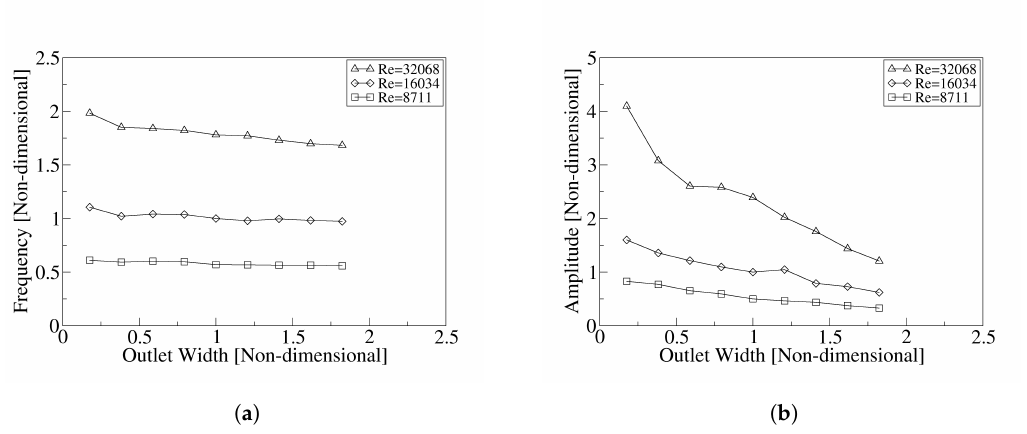
Figure 7. Fluidic oscillator output mass flow frequency ( a ) and peak to peak amplitude ( b ) as a function of the mixing chamber outlet width and for three different Reynolds numbers, 8711, 16034 and